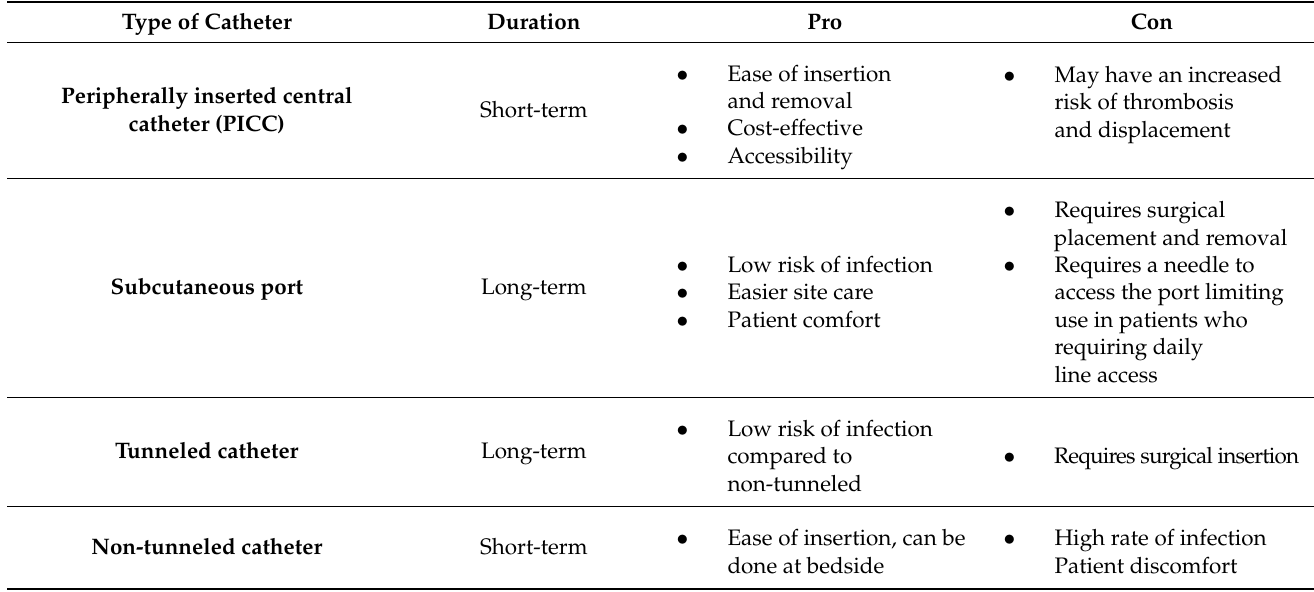
Table 2. Central venous